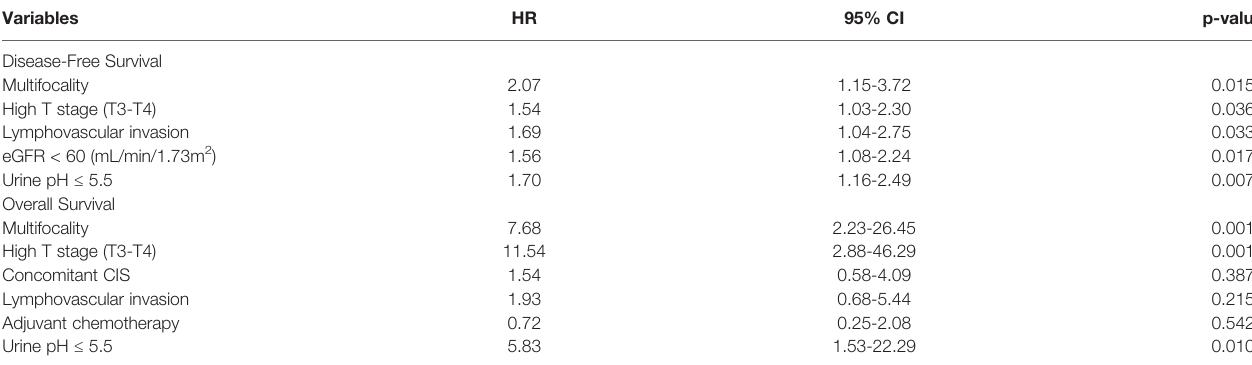
TABLE 5 | Multivariate Cox regression analysis of disease-free survival and overall survival. Variables HR Disease-Free Survival